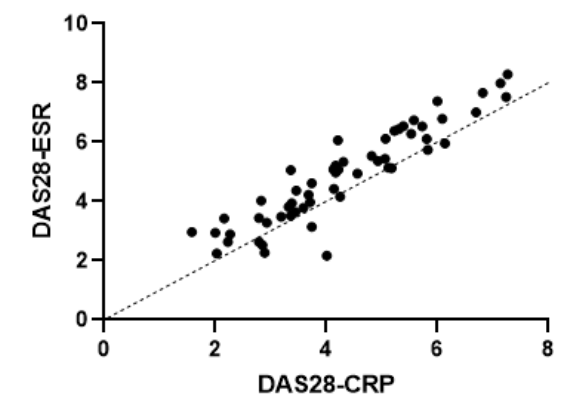
TABLE II - Characteristics of the patients (n = 56 patients)